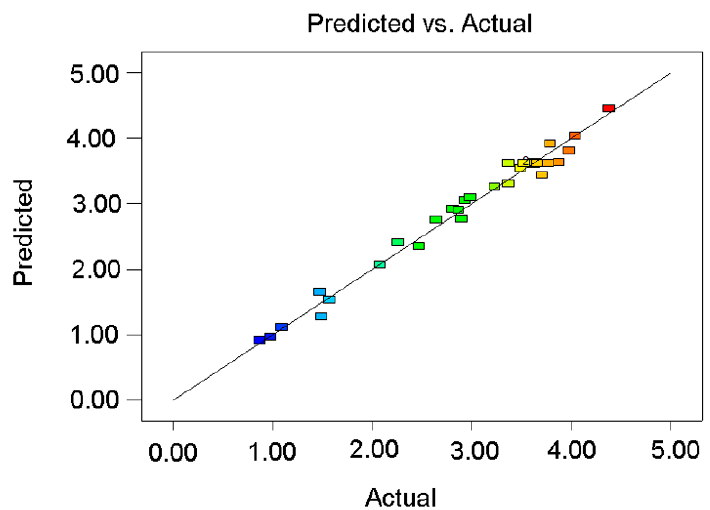
Figure 7. Goodness-of-fit of predictive and actual values of the polynomial model.